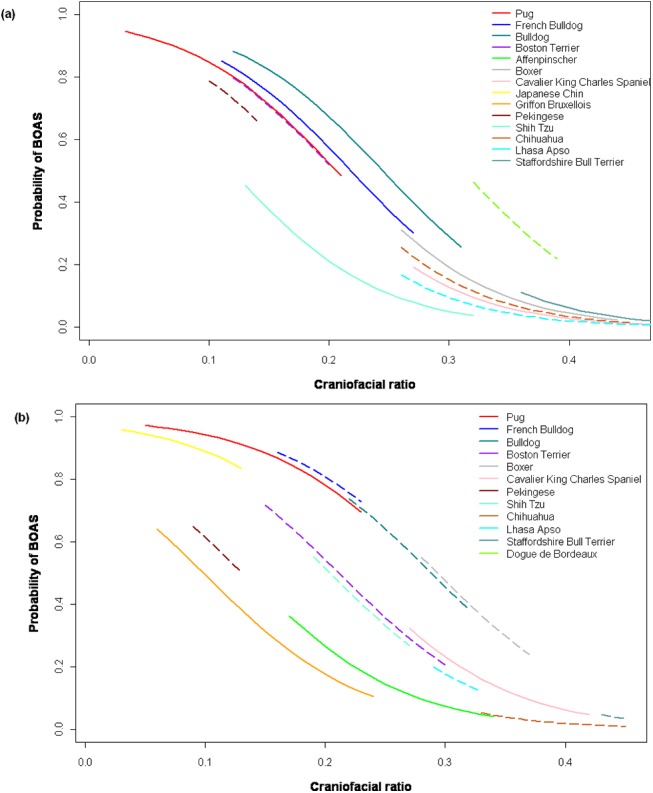
(a) (b) Predicted probability of brachycephalic dog breeds being affected by brachycephalic obstructive airway syndrome (BOAS) across relevant craniofacial ratio (CFR) and neck girth ranges.The risks across the CFR spectrum are calculated by breed using GLMM equations based on (a) Study 1 referral population data and (b) Study 2 non-referral population data. For each breed, the estimates are only plotted within the CFR ranges observed in the study populations. Dotted lines show breeds represented by <10 individuals. The breed mean neck girth is used for each breed (as stated in Table 2). In (b), the body condition score (BCS) = 5 (ideal bodyweight) and neuter status = neutered.